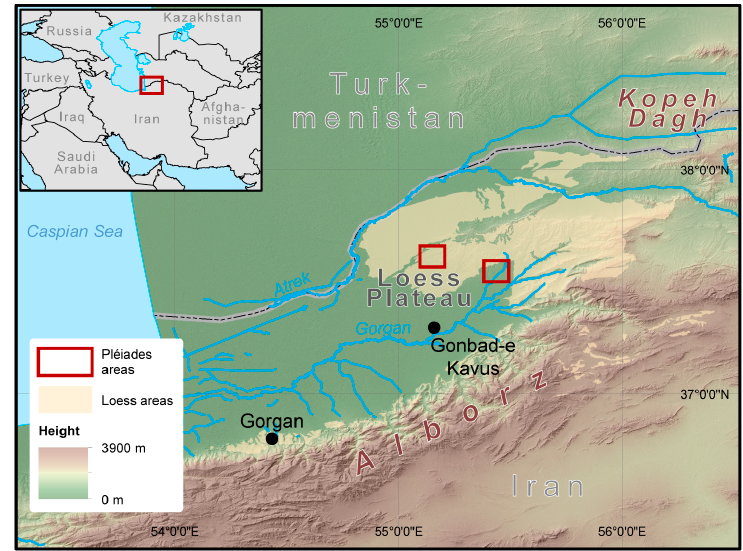
Figure 1. Overview of the study area in northeast Iran with the two different Pl é iades satellite imagery extents. Data provided by Golestan Natural Resources and Watershed Management Central Office (loess areas), ASTER-GDEM2 and ArcWorld